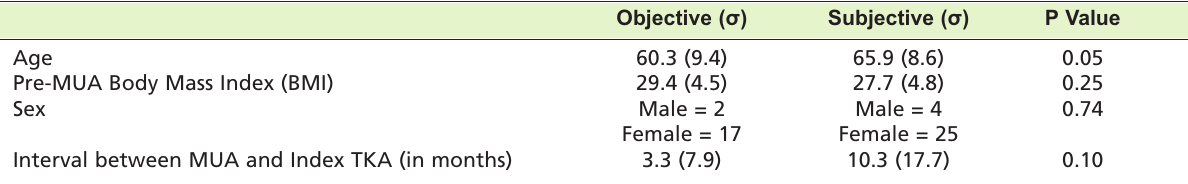
Demographic comparison between Objective and Subjective Knee Stiffness Groups Table I: